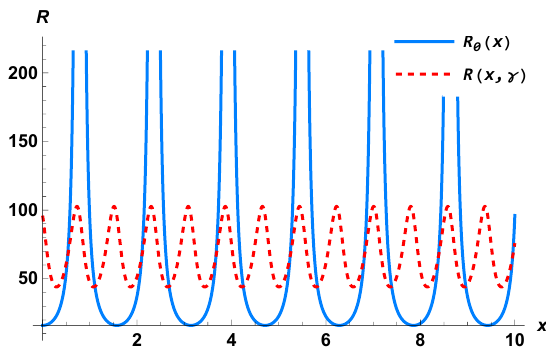
Figure 6 . The blue solid line denotes the scalar curvature of the perturbative solution and the dashed red line represents the non-perturbative regular